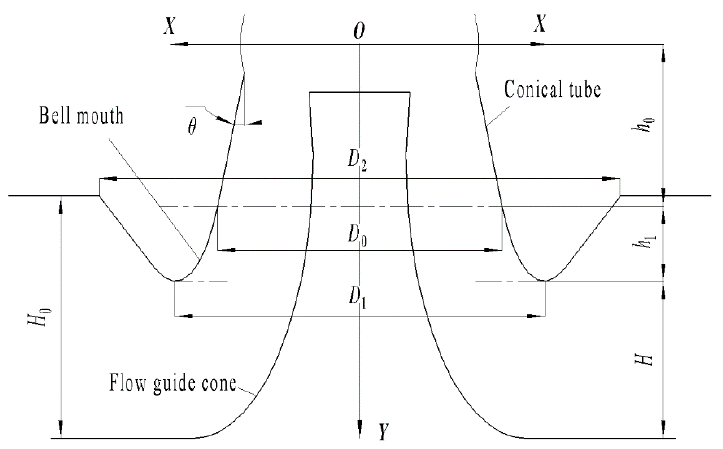
Figure 3. Schematic diagram of the bell mouth.